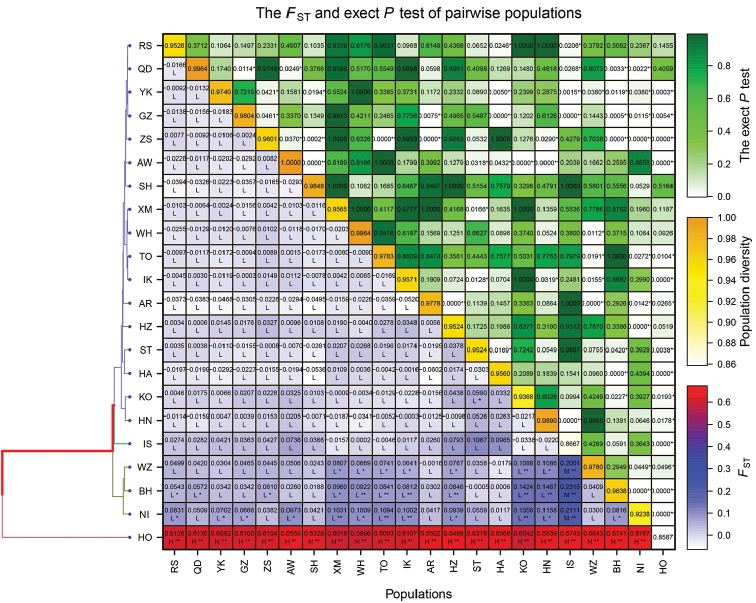
The heatmap of Fst genetic distances based on mtDNA control sequences of populations.